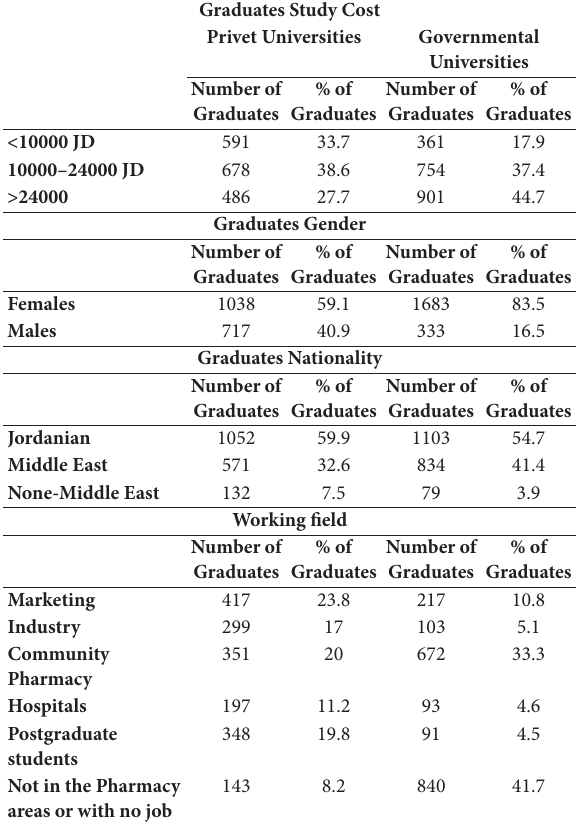
Table 1. Pharmacists’ diversity between private and govern-